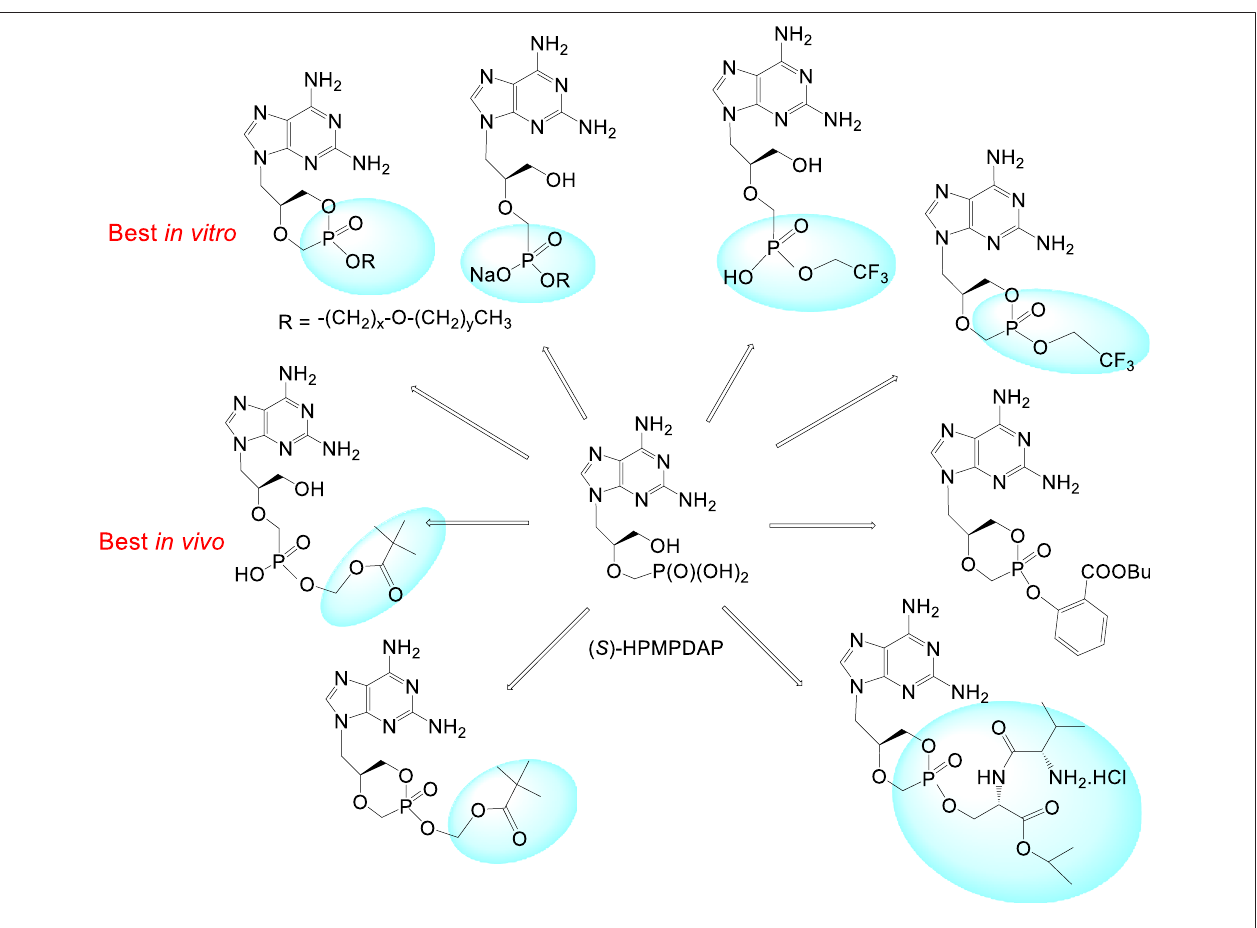
FIGURE 12 | Prodrugs derived from ( S )-HPMPDAP as antipox virus agents.